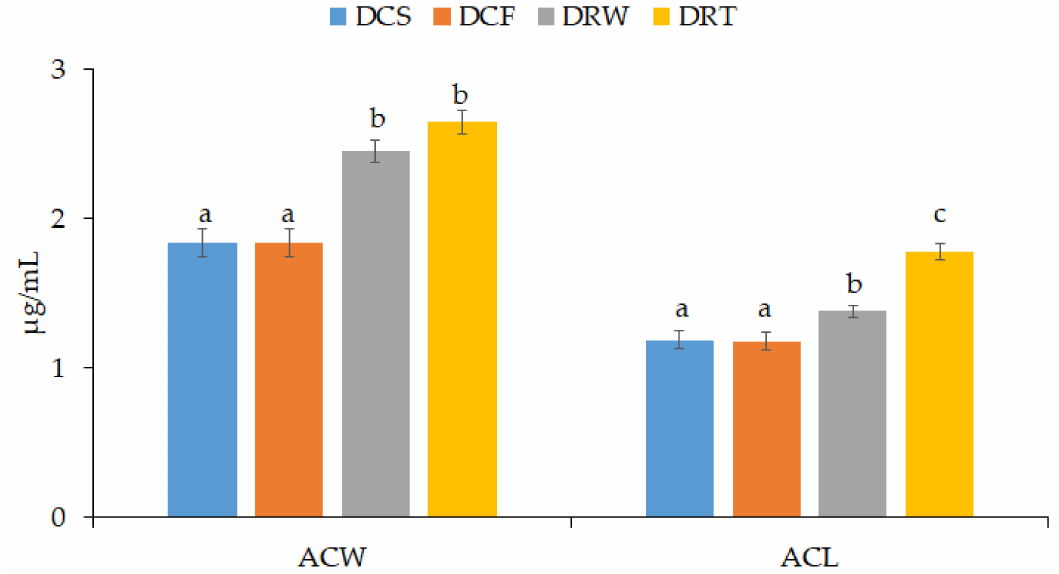
Figure 1. The antioxidant capacity of water-soluble and lipid-soluble substances in the serum. Diet: D CS —control standard diet, D CF —control high-fat diet, D RW —diet enriched with freeze-dried raw cocoa beans extract, D RT —diet enriched with freeze-dried roasted cocoa beans extract. Results are